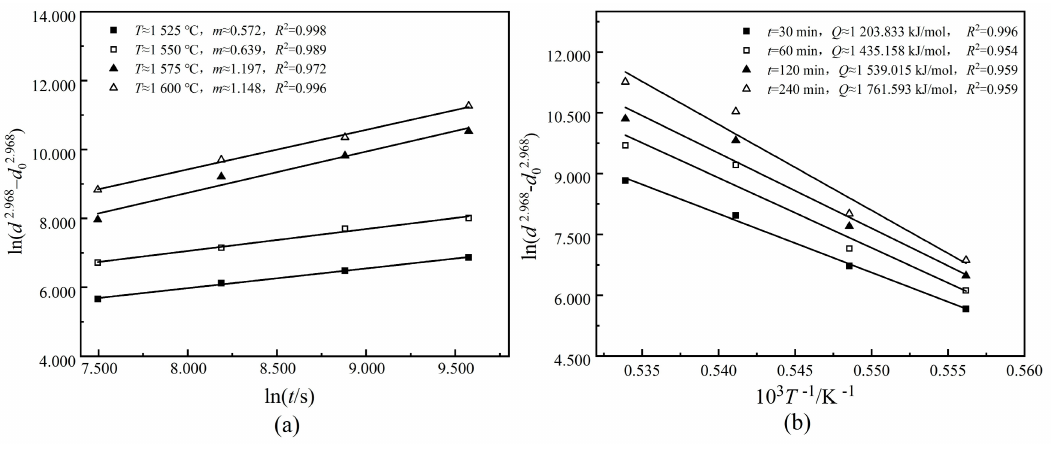
Figure 7. Linear relationship curves of ln ( d 2.968 − d 2.968